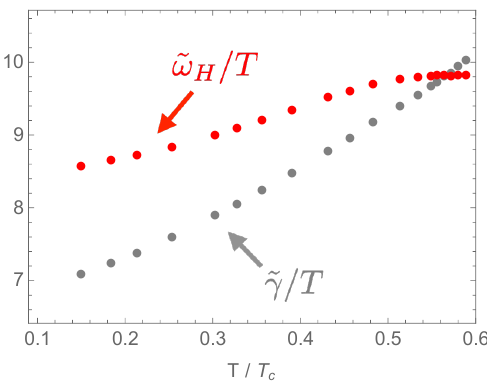
Figure 16 . The phenomenological parameters of GL theory, ( ˜ ω H , ˜ γ ). The Higgs frequency ˜ ω H and the Higgs attenuation constant ˜ γ at λ/T = 0 . 1